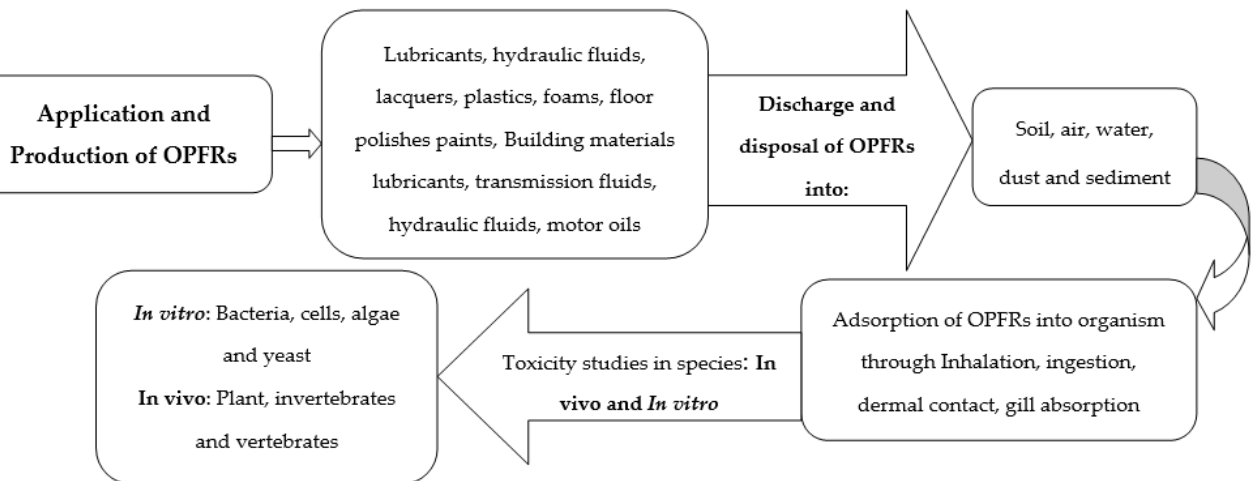
Figure 3. A schematic diagram of OPFRs action in toxicology [11].